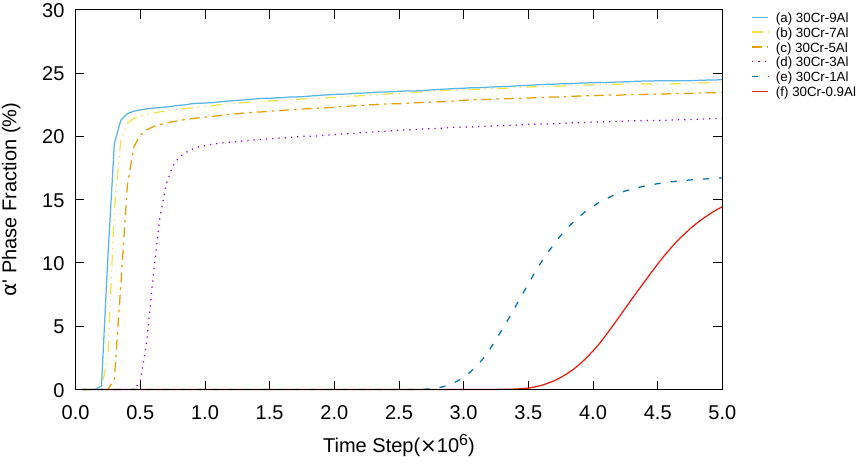
Figure 2. α (cid:48) phase fraction of the 2D simulation at an average Cr concentration of 30% when the average Al concentration was ( a ) 9%, ( b ) 7%, ( c ) 5%, ( d ) 3%, ( e ) 1%, and ( f )